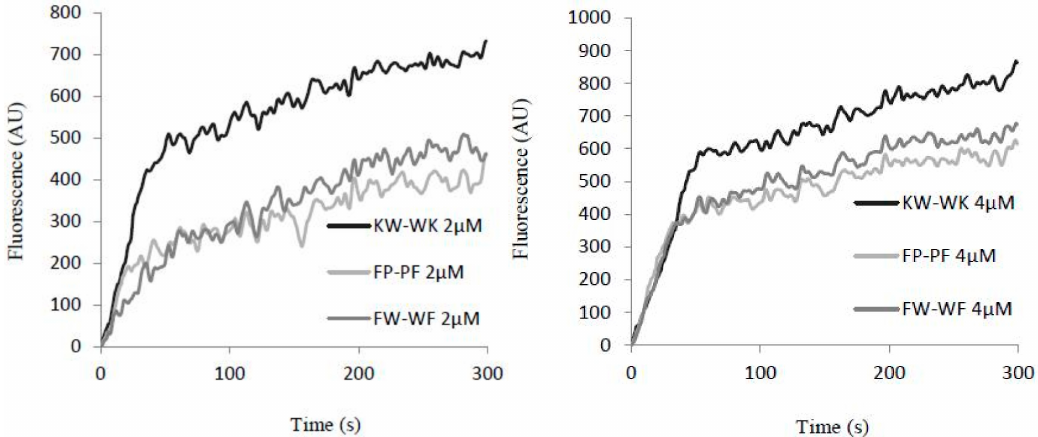
Figure 7. Cytoplasmic membrane depolarization of E. coli UB1005 follow treatment with the antimicrobial peptides at concentrations of 2 µ M and 4 µ M assessed by release of the membrane potential-sensitive dye